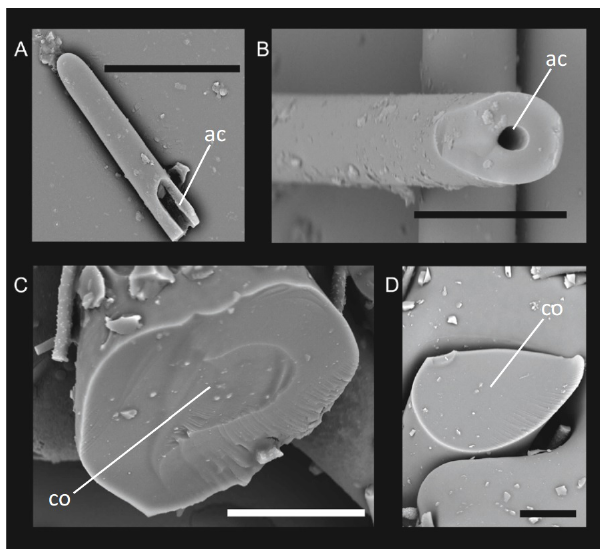
Figure 6. Scanning electron microscope images of fracture plane of Asbestopluma sp. spicules. ( a and b ) Megascleric styles showing the internal axial canal (ac) (scale bar 30µm). ( c and d ) Core area (co) of anaxial desmas of the cladorhizid DH19-2 showing the absence of axial canal (scale bar